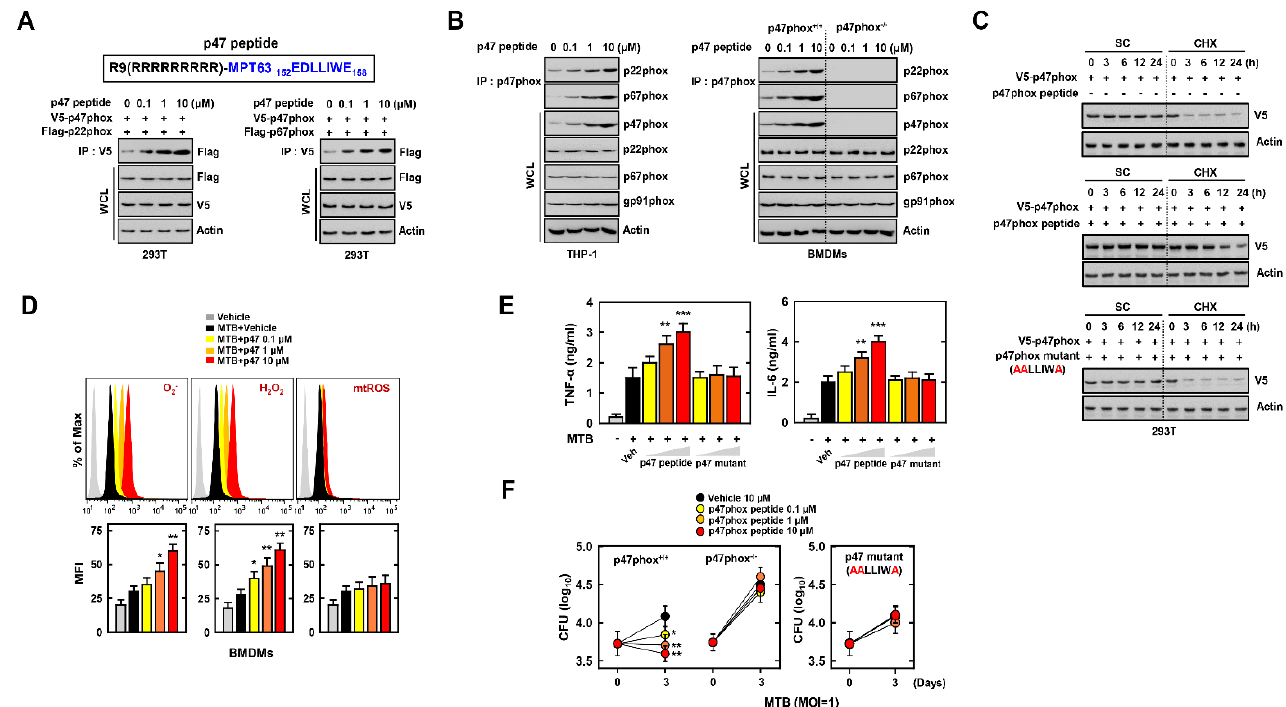
Figure 4. p47 peptide enhances inflammation against MTB by elevating the level of ROS. ( A ) Schematic design of p47 peptide (upper). 293T cells were transfected with V5-p47phox and Flag-p22phox or Flag-p67phox and treated p47